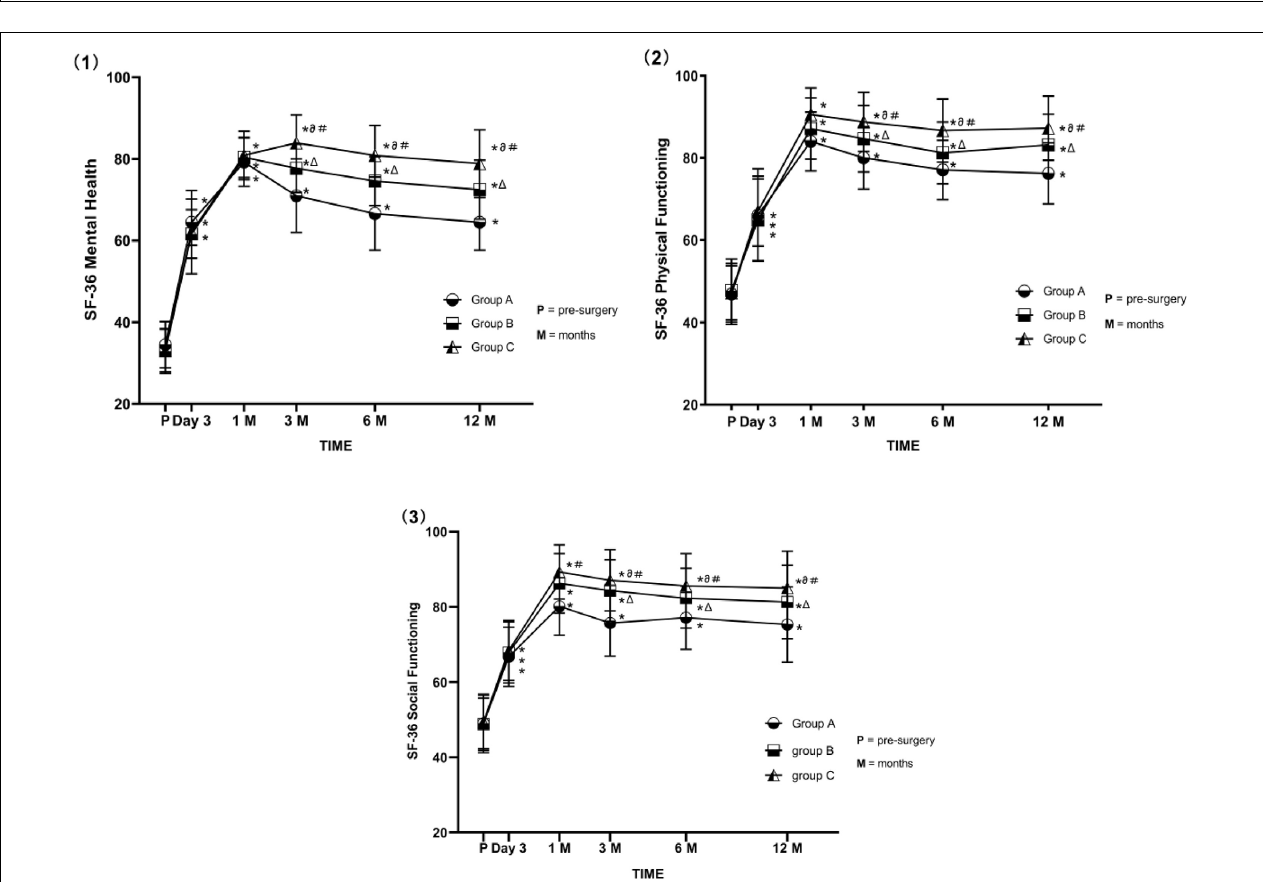
FIGURE 4 | (1–3) Comparison of SF-36 (Physical Functioning, Mental Health, Social Functioning) scores before and after PRF in the three groups. Group A (45 V PRF); Group B (55 V PRF); Group C (65 V PRF). Results are presented as mean ± SD. Compared to pre-surgery SF-36 scores, * P < 0.05; group B compared to group A, (cid:49) P < 0.05; group C compared to group A, ∂ P < 0.05; group C compared to group B, # P < 0.05.